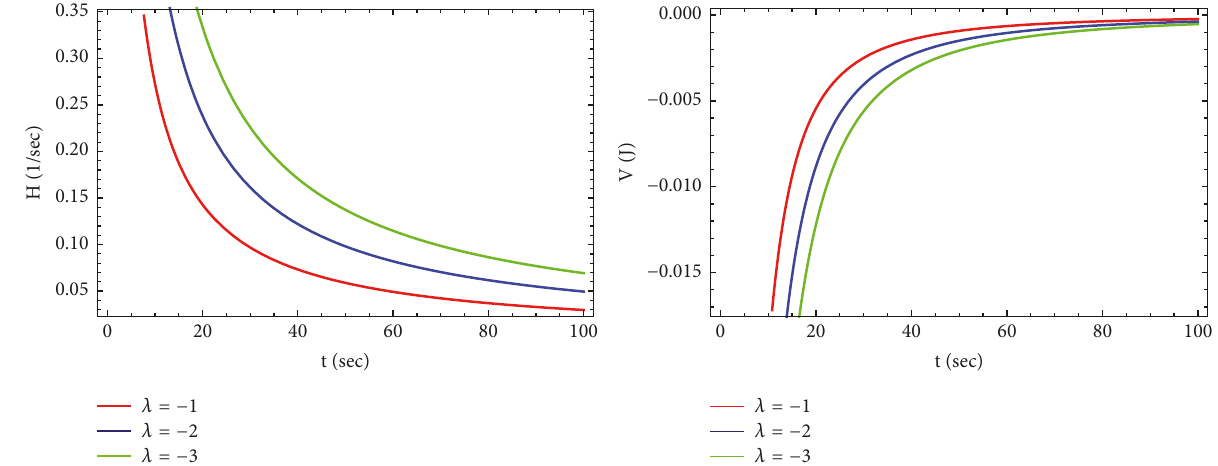
Figure 1: Plots of 𝐻 and 𝑉 versus 𝑡 for 𝑊(𝜑) = 𝑒 𝑏 1 𝜑 , 𝑏 1 = 1(1/𝑠𝑒𝑐) , and 𝑐 1 = 1 when 𝑘 = 0 .